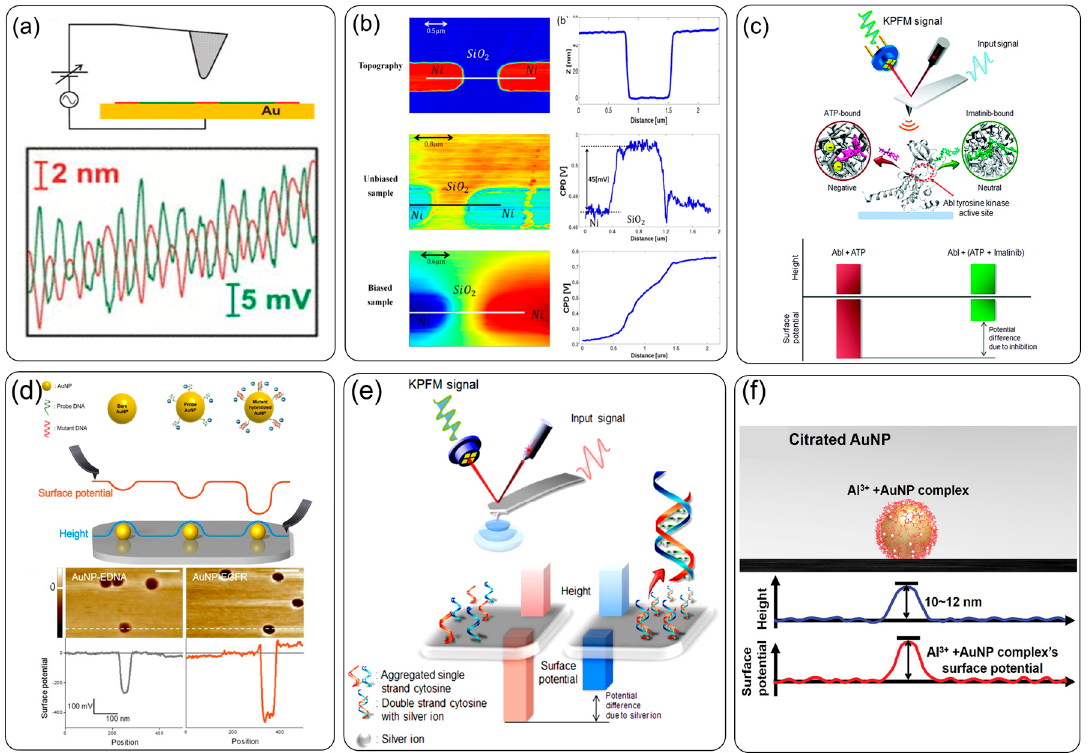
Figure 2. Kelvin probe force microscopy (KFM) for surface potential images: ( a ) schematic diagram of the detection in air (top graph), and in the bottom graph, the red line represents the topography for fibril, and the green line represents the surface potential [30]; ( b ) the morphology and contact potential difference for metal contacts on SiO 2 surface for unbiased and biased sample [34]; ( c ) recognition of single-molecule interaction between protein and small ligands [35]; ( d ) DNA on a gold nanoparticle (AuNP) for mutation study by comparing the height and surface potential signals [36]; (f) single-molecule detection of avidin molecules and DNA [37]; ( e ) Ag + ion adsorption to aptamers [39]; and ( f ) Al 3+ ion detection on citrated AuNPs [40].